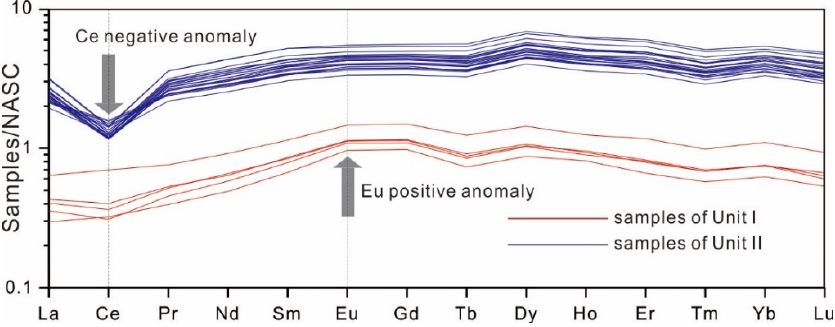
Figure 7. The NASC-normalized REE patterns of sediments from core PC15.